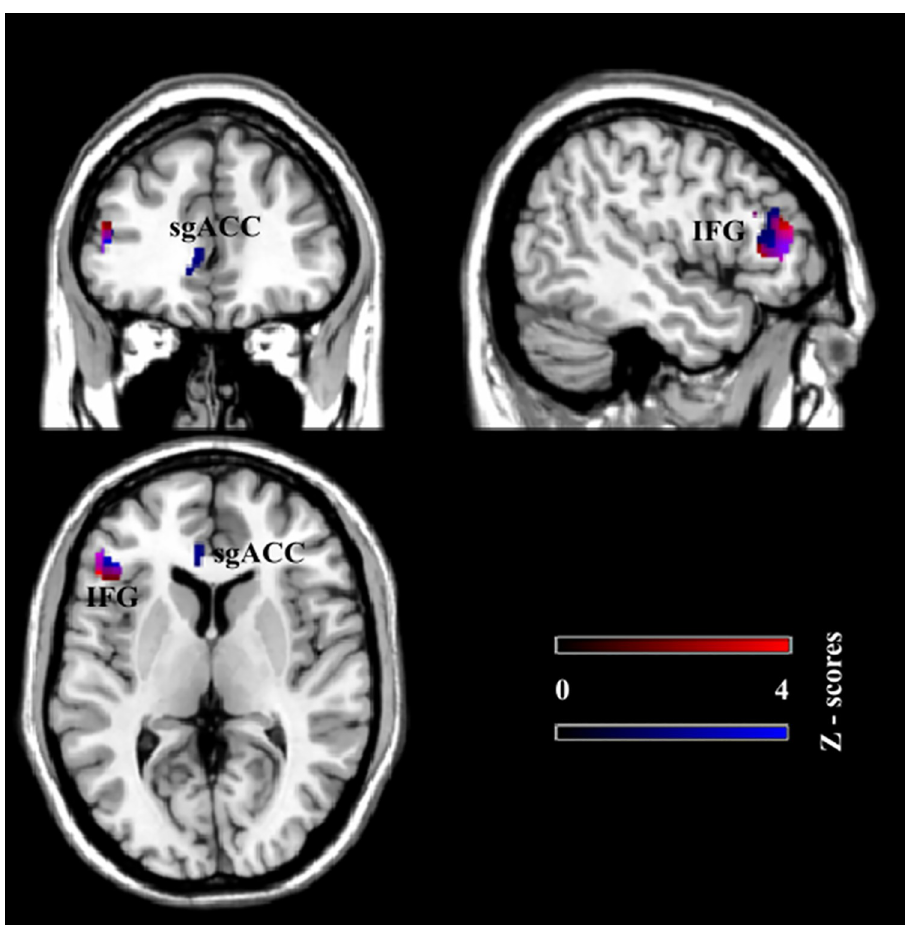
Fig 3. Correlations of the CBF contrast of exclusion minus inclusion with subjective feelings of being rejected and victim scores positive correlations of the CBF contrast of exclusion minus inclusion with subjective feelings of being rejected (NTS, red) and victim scores (BVF-K, blue). Overlap occurs in left